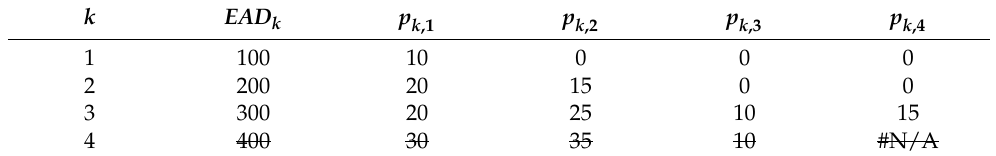
Table 6. Portfolio with K = 4 debt positions and 4 periods of delay, excluding the loan with missing data.